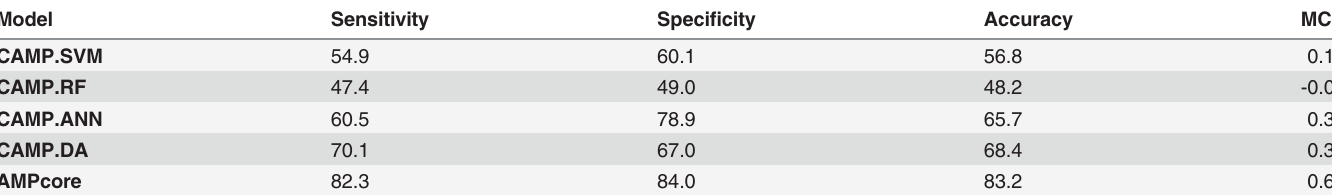
Table 4. Performance comparison with AMP prediction models on the low similarity dataset of 510 AMP